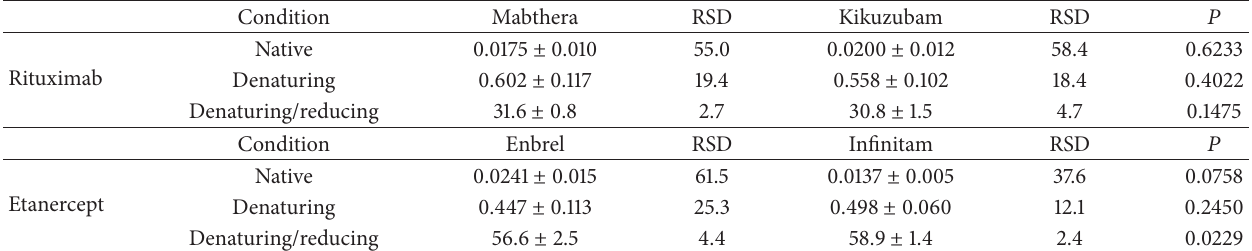
Table 2: Thiol quantification using DTNB method. Rituximab and Etanercept free thiols under native, denaturing, and denaturing-reducing conditions using DTNB method. Uncertainty values are presented in SD ( 𝑛 = 9